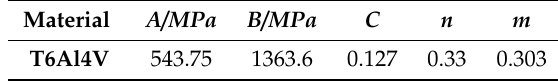
Table 1. Johnson–Cook constitutive parameter of Ti6Al4V